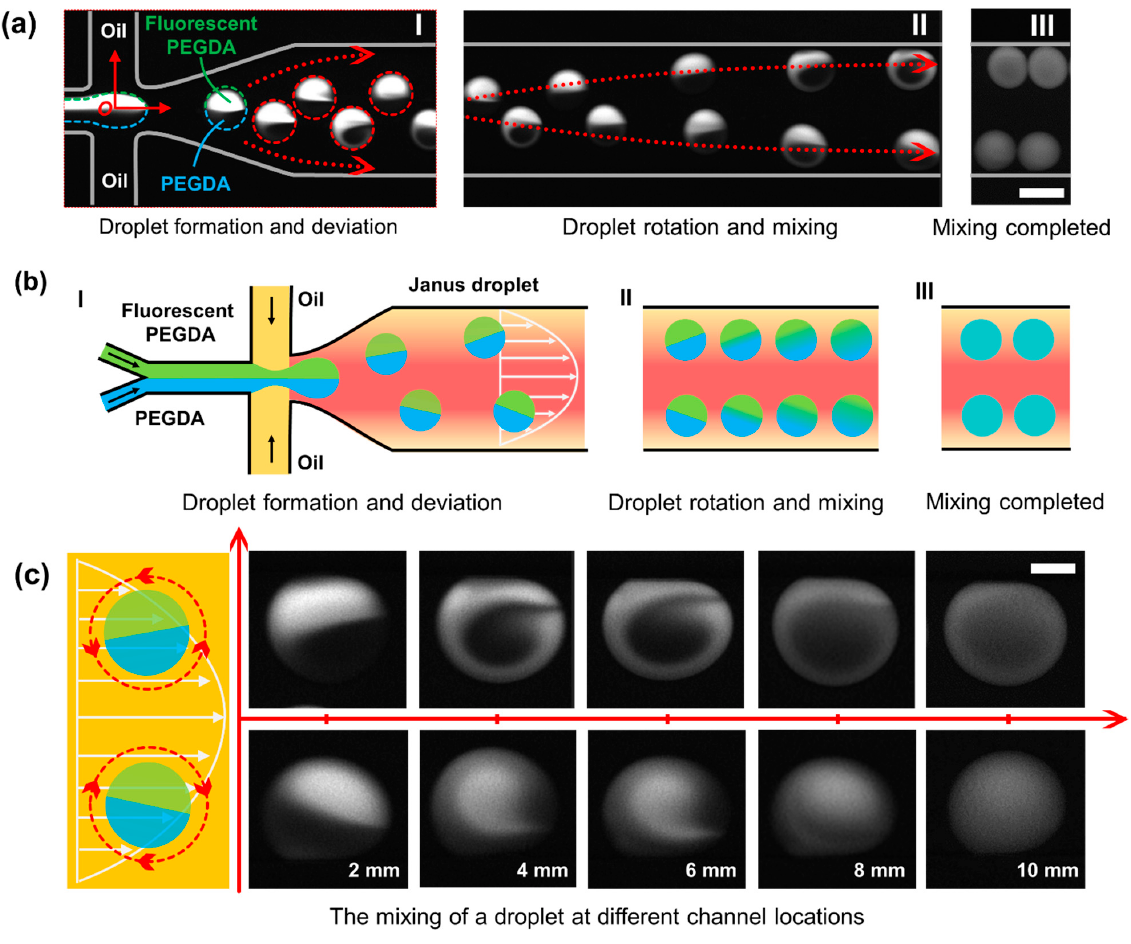
Figure 2. Fluorescence images obtained through the microscope and CCD camera. ( a ) I : Droplet formation and trajectory deviation (red dash line). II : Droplet rotation and mixing. III : Droplet mixing completed. Scale bar is 100 μ m. ( b ) Schematics of the droplet generation and droplet mixing. ( c ) The rotating droplets at different positions. Scale bar is 40 μ m. As shown in Figure 2c, the distribution of the flow field is non-uniform, and the flow velocity is parabolic along the transverse direction of the microchannel. When the droplet is located in the channel center, the two halves of the droplets are balanced, and no rota- tion occurs. However, when the droplet deviates away from the centerline, the two halves of the droplet are not uniformly stressed, and the rotation occurs. Duo to the symmetry of the flow field, the upper droplets rotated counterclockwise while the lower droplets rotate clockwise. The rotation introduced turbulence and destroyed the barrier between the two inner liquids, which increased the contact area and increased the diffusion flux. The series of pictures right-side shows the mixing state of the droplet at different positions (a corre- sponding video is provided in Supplementary Materials Video S1). In fact, the rotating mechanism is a complex phenomenon involving the understand- ing of non-uniform flow field, non-uniform mass distribution between the two halves within the droplet, and their strong dynamic coupling, which is beyond the scope of this study. For example, the subsidence of the channel roof will affect the distribution of the flow field, transforming it from a two-dimensional parabolic distribution to a three-di- mensional complex distribution, resulting in the 3D rotation of the droplet. Other disturb- ances seemingly weak can also affect the direction and speed of rotation, such as the small difference in density or viscosity between the two halves of the droplet.